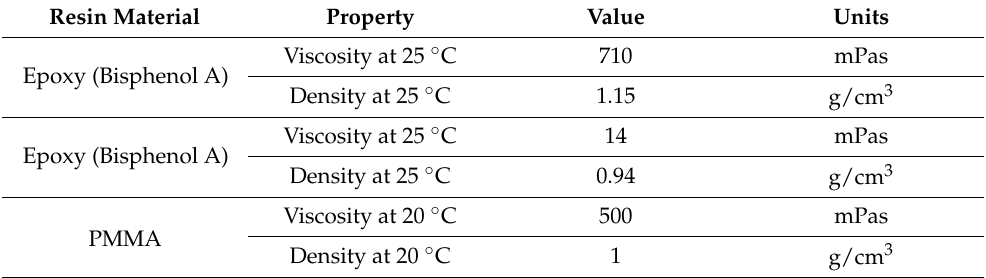
Table 2. Resin viscosity and density.